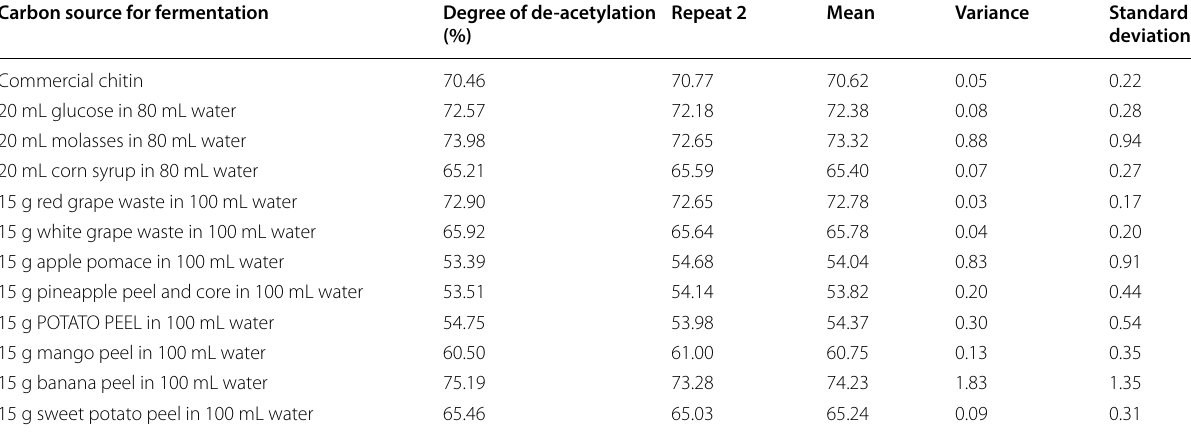
Table 6 Statistical analysis of degree of deacetylation of chitin extracted after fermentation on various carbon sources Carbon source for fermentation Degree of de‑acetylation (%)